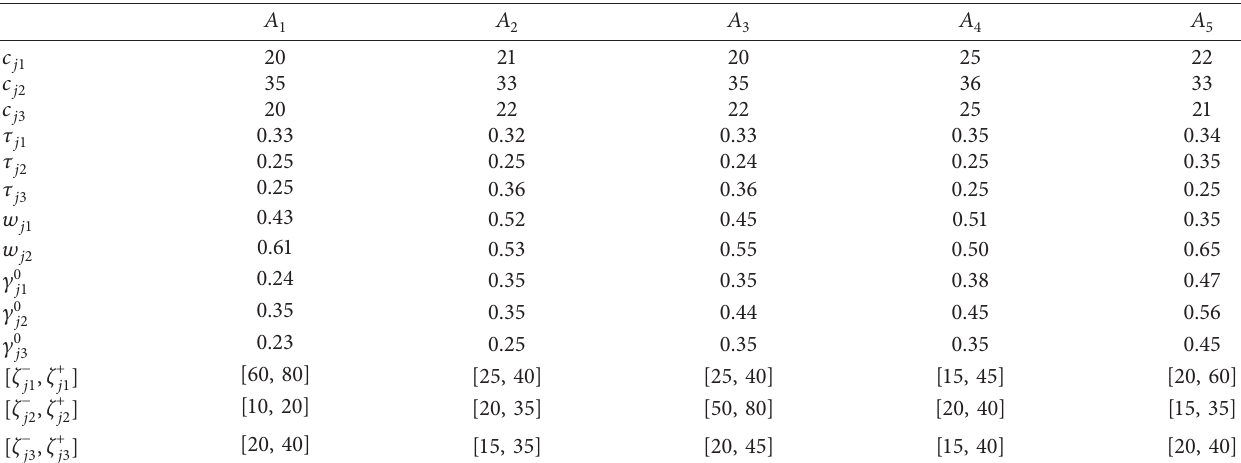
Figure 2: Illustration of annual demand in several big cities. Table 5: Parameter values.